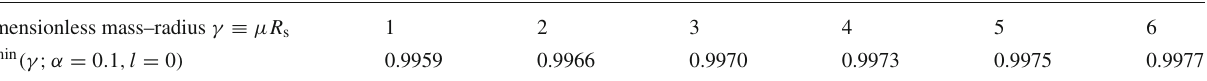
Table 2 Resonant oscillation frequencies of the composed stationary compact-reflecting-star–linearized-massive-scalar-field configurations with α = 0 . 1and l = 0.Wedisplaythesmallestresonantoscillationfre- quency (cid:16) min (γ) of the stationary bound-state massive scalar fields for various values of the dimensionless mass–radius parameter γ ≡ μ R s .